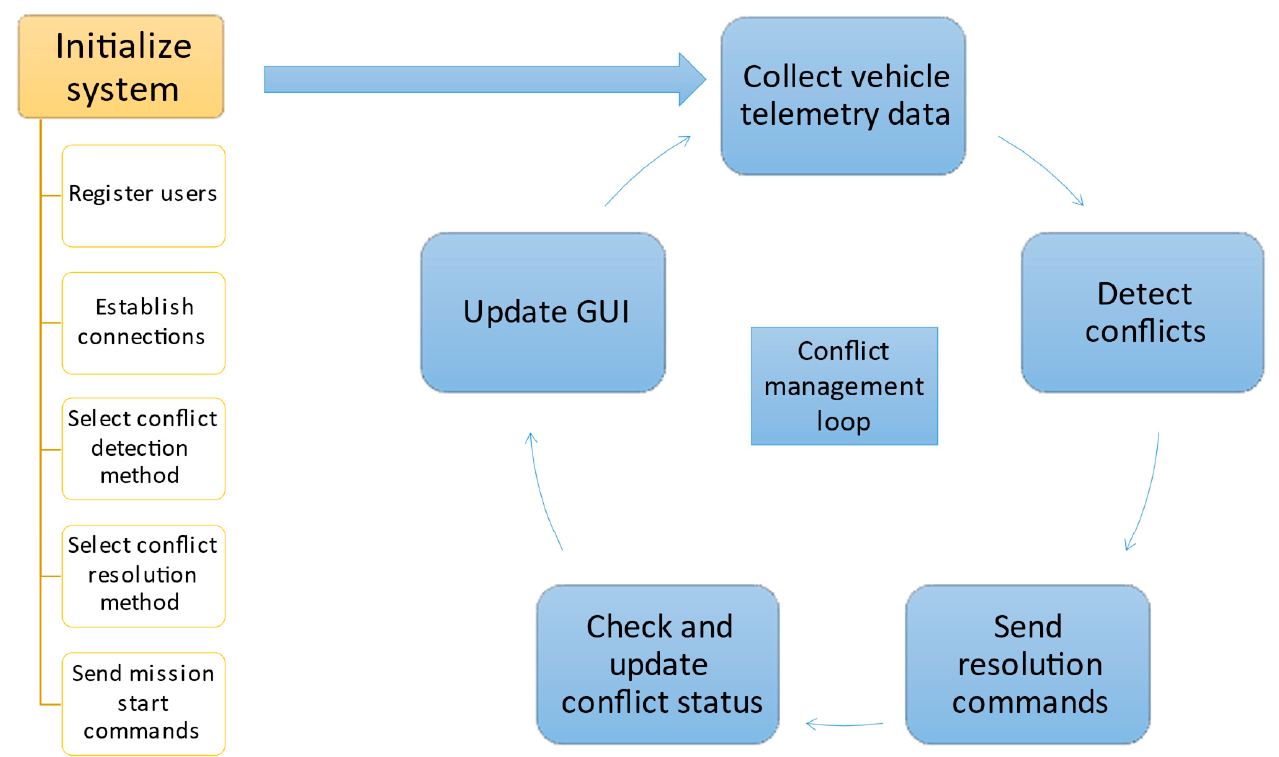
Figure 2. Top level flow diagram of first framework version.